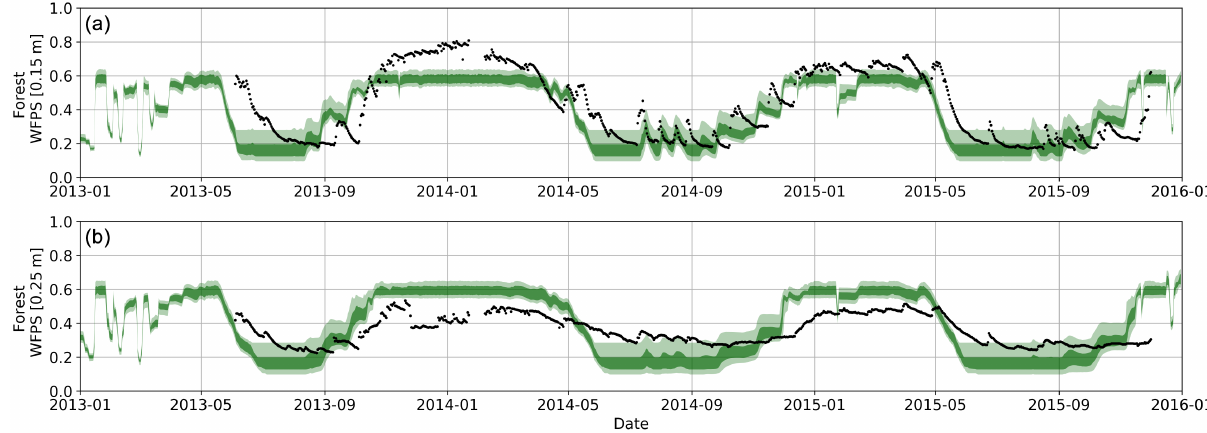
Figure A3. Modelled WFPS on forest in different depths. RMSEs ranging from 0.0817 to 0.1324% WFPS (0.15m) and 0.0812 to 0.1606% WFPS (0.25m).